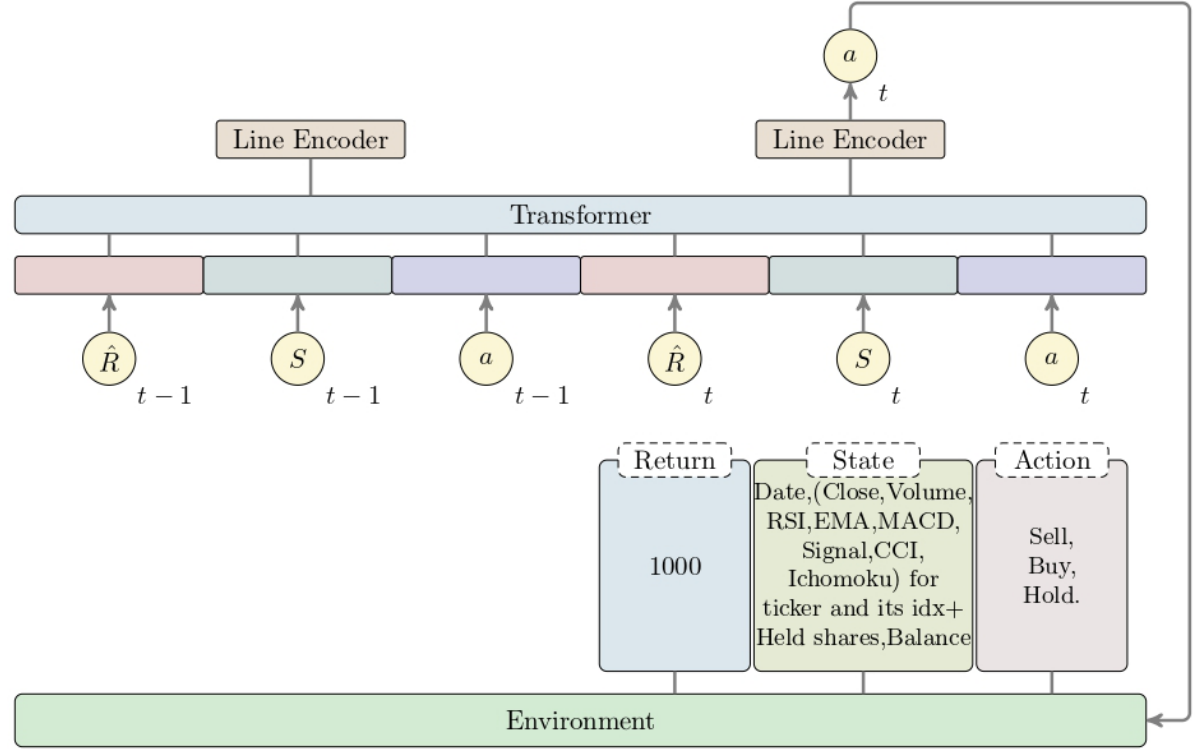
Figure 13. Model